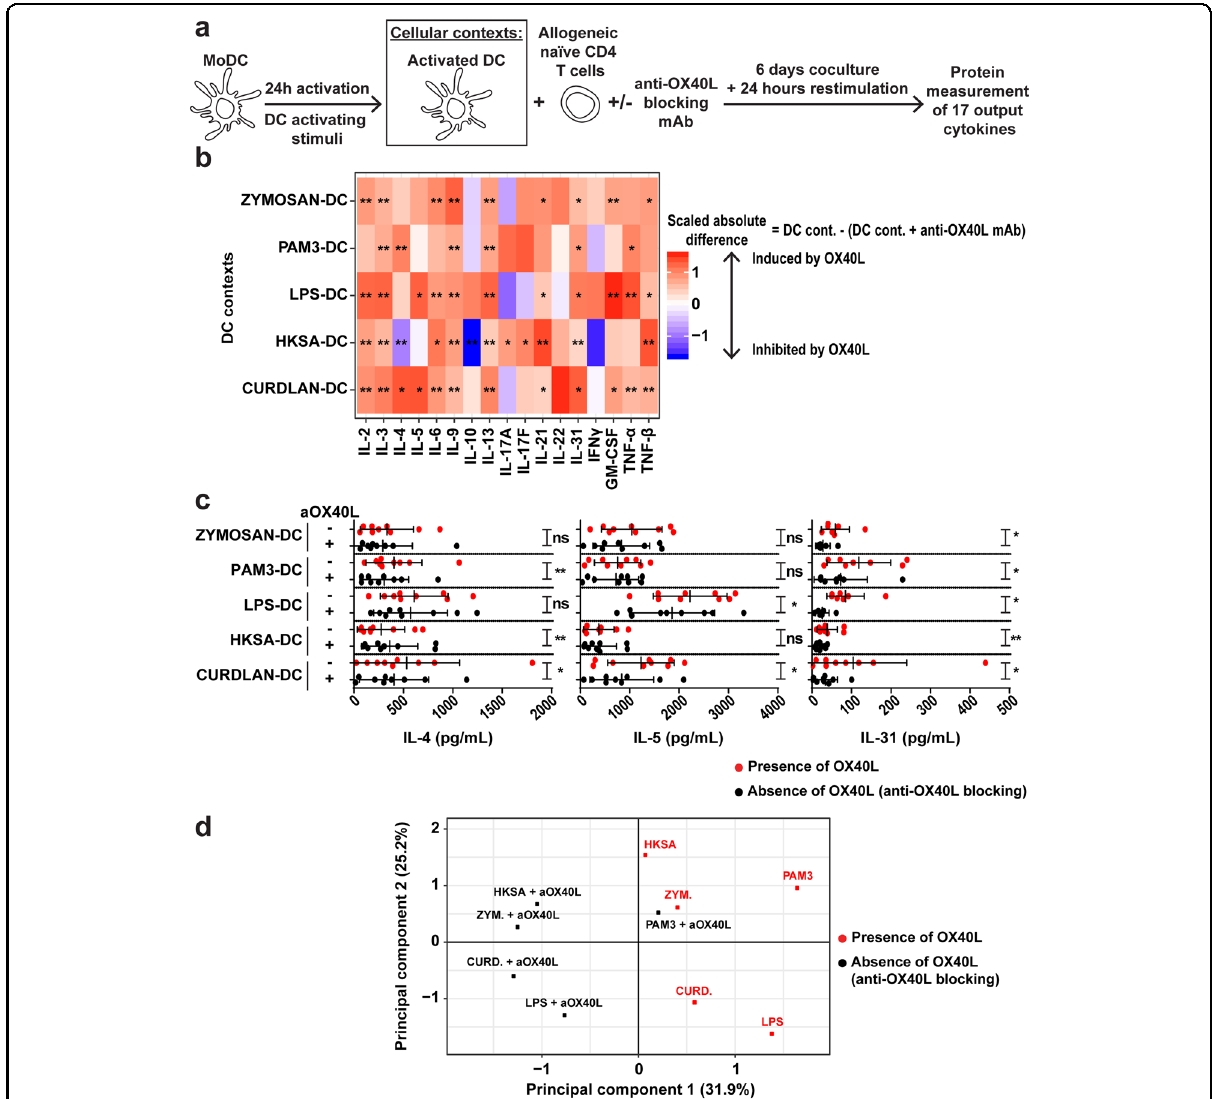
context. The absolute difference corresponds to the concentration of a given cytokine in a MoDC context in the presence of the isotype (DC cont.) subtracted by the concentration of the cytokine in that MoDC context in the presence of anti-OX40L antibody (DC cont. + anti-OX40L mAb). The mean is represented. Paired Wilcoxon ’ s test was used for statistical analysis. c IL-4, IL-5 and IL-31 production in each MoDC context in the presence of anti-OX40L blocking antibody (black dots) or isotype (red dots). Data are the means ± SD and individual values are represented. Paired Wilcoxon ’ s test was used for statistical analysis. d PCA representing the barycenters of the fi ve MoDC contexts in the presence (black dots) or absence (red dots) of anti-OX40L blocking antibody, meaning absence and presence of OX40L on MoDC, respectively. Nine independent donors were used in each analysis. ns, no signi fi cance; * P ≤ 0.05; ** P ≤